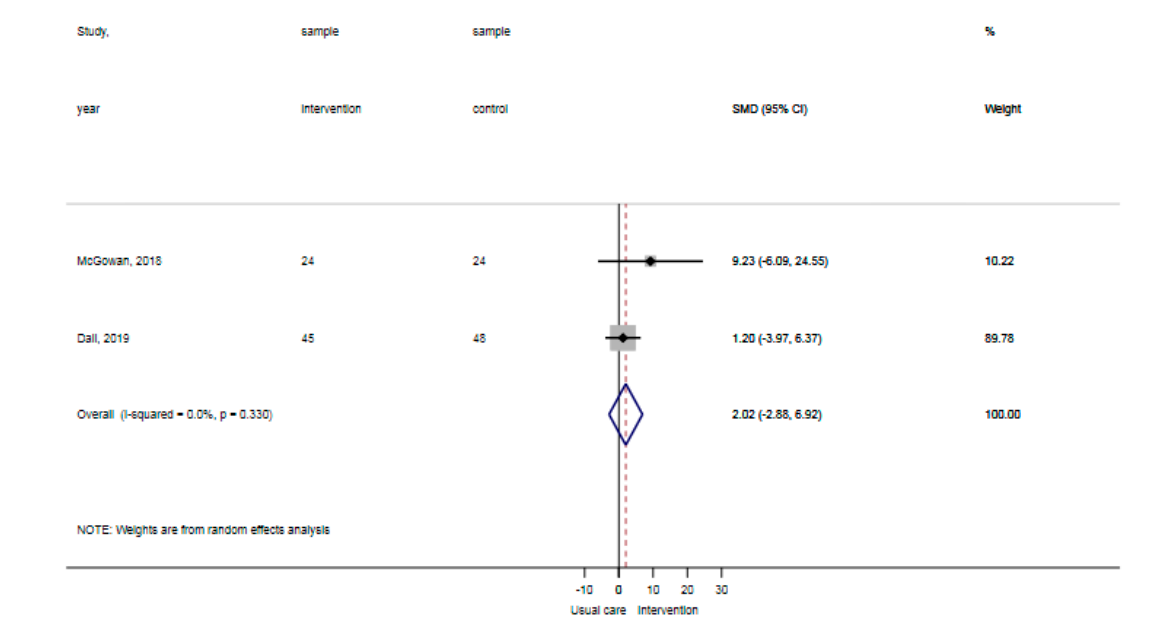
Figure 2. Forst plot activities of daily living (ADL)-activity performance showing no statistically significant difference between usual care and intervention.